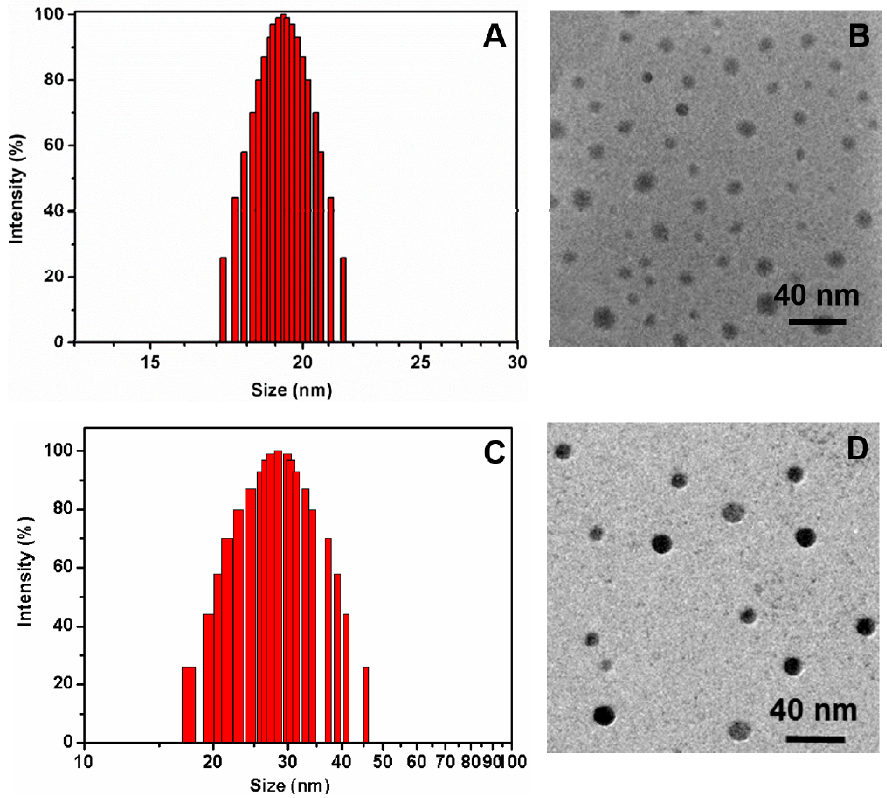
Figure 5. DLS plots ( A , C ) and TEM images ( B , D , discrete and spherical blackspots) of blank ( A , B ) and IMQ-loaded ( C , D ) β -CD-(PLA- b -PDMAEMA- b -PEtOxMA) 21 micelles.